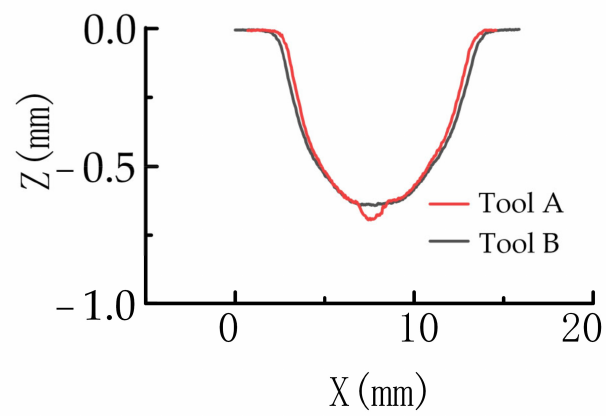
Figure 7. Grooves machined by different tool A and tool